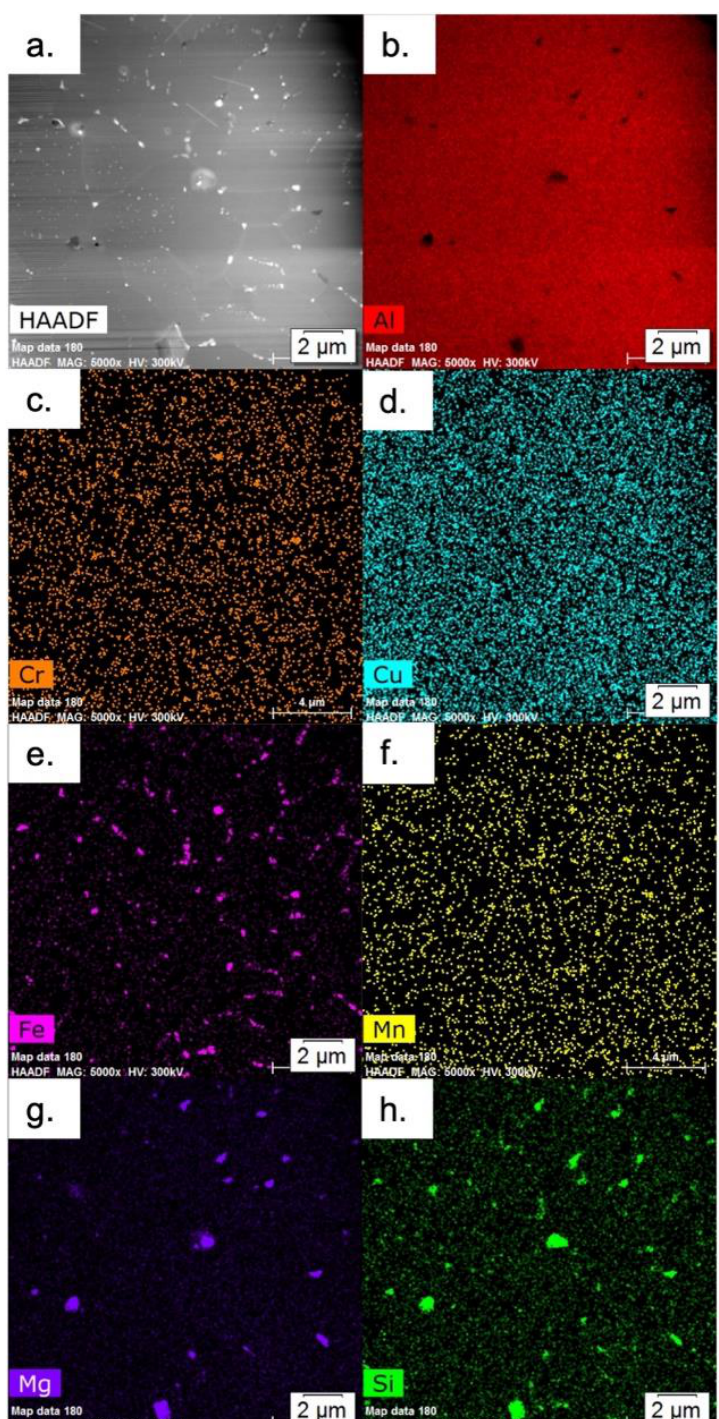
Figure 6. Overview images of the thermally treated powder: ( a ) HAADF, and EDS maps of ( b ) Al,